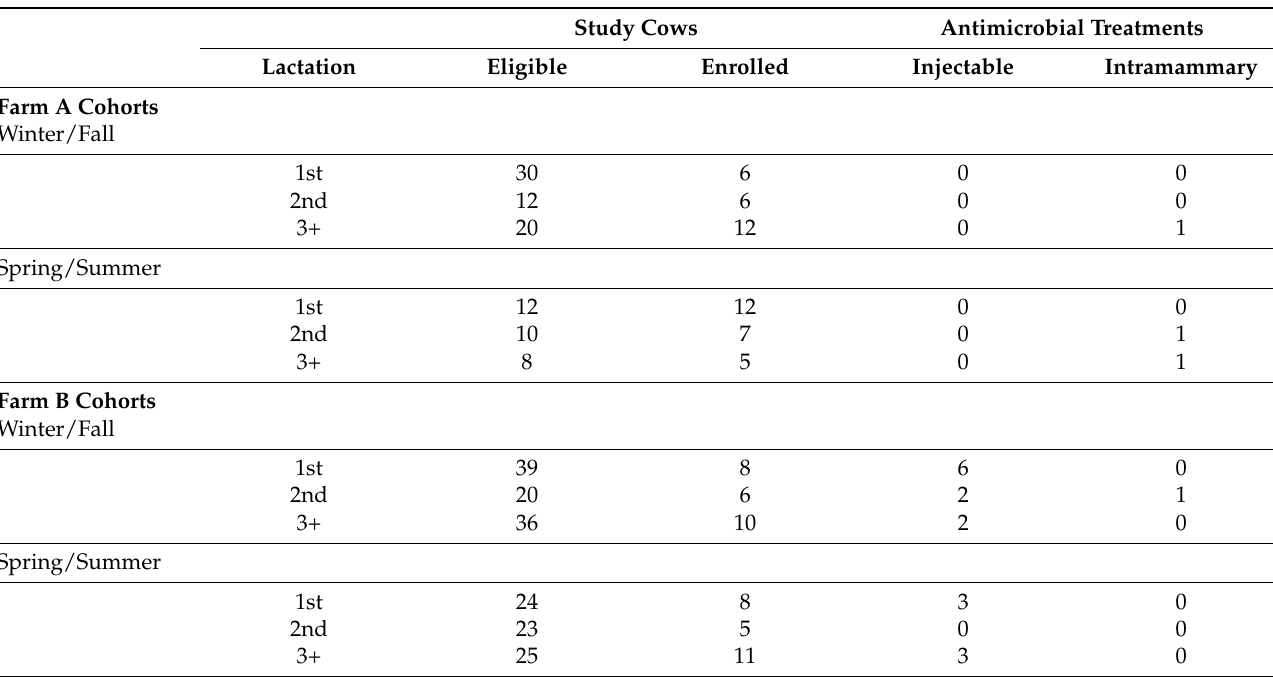
Table 2. Enrollment counts, lactation group structure and antimicrobial treatments for study cohorts. Study Cows Antimicrobial Treatments Lactation Eligible Enrolled Injectable